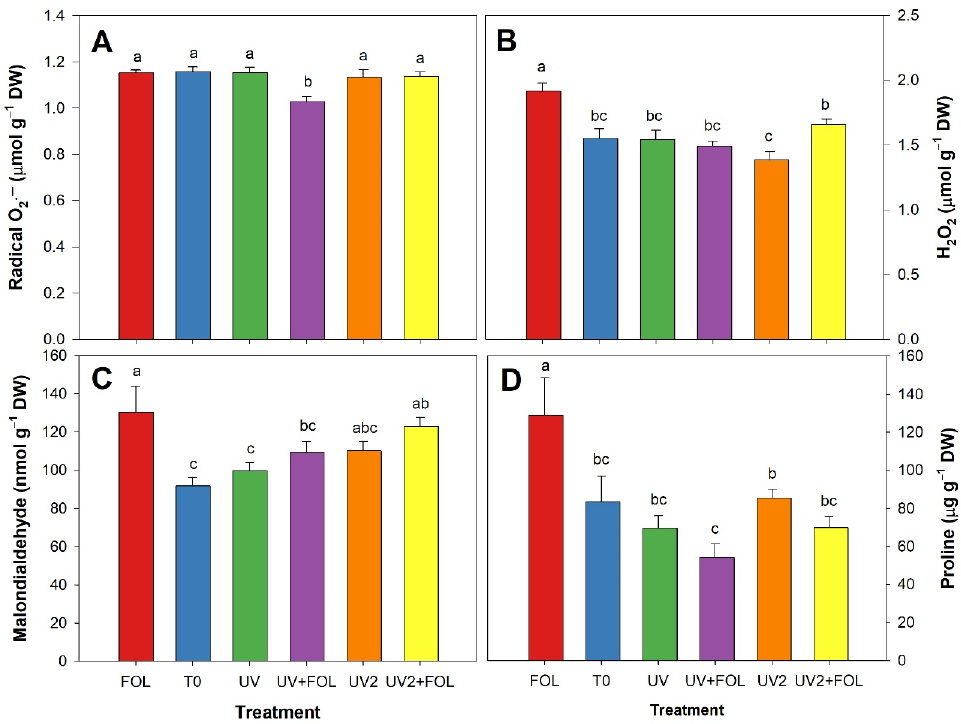
Figure 4. Stress biomarkers in leaves of tomato plants inoculated with Fol and supplemented with UV-A radiation. ( A ) Superoxide radical, ( B ) Hydrogen peroxide, ( C ) Malondialdehyde, and ( D ) Proline. The leaf samples (fully expanded young leaves) were collected 17 weeks after transplanting. Different letters between treatments indicate significant differences according to Fisher ´ s Least Significant Difference test ( p < 0.05). n = 6 ± standard error. T0, negative control (tomato plants without UV-A radiation and without Fol inoculation); FOL, positive control (tomato plants only inoculated with Fol); UV, tomato plants supplemented with UV-A radiation through one LED lamp; UV + FOL, tomato plants supplemented with UV-A radiation through one LED lamp and inoculated with Fol; UV2, tomato plants supplemented with UV-A radiation through one LED lamp above of the plant canopy plus one fi xed lamp at the plants’ bo tt om; and UV2 + FOL, tomato plants inoculated with Fol and supplemented with UV-A radiation through one LED lamp above the plant canopy plus one fi xed lamp at the bo tt om of the plants.